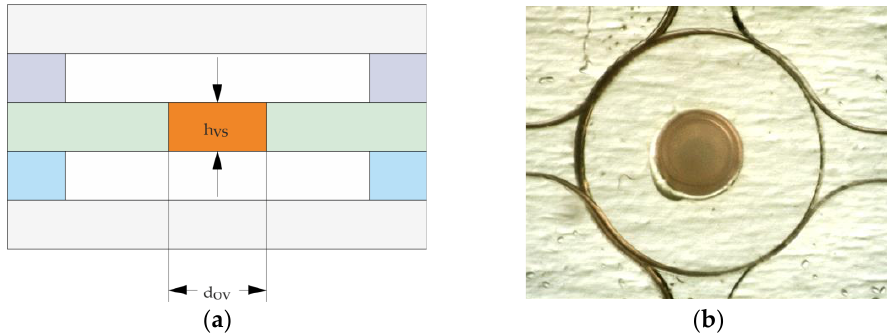
Figure 4. ( a ) Schematic cross-section of opening valve layer stack; orange — PEG element, blue and violet — fluidic layers.; thickness of the foil with the hole, h VS, and diameter of the hole, d OV . ( b ) Top view of cured PEG element positioned in 500 µm hole (d OV ) and placed between microfluidic layers.